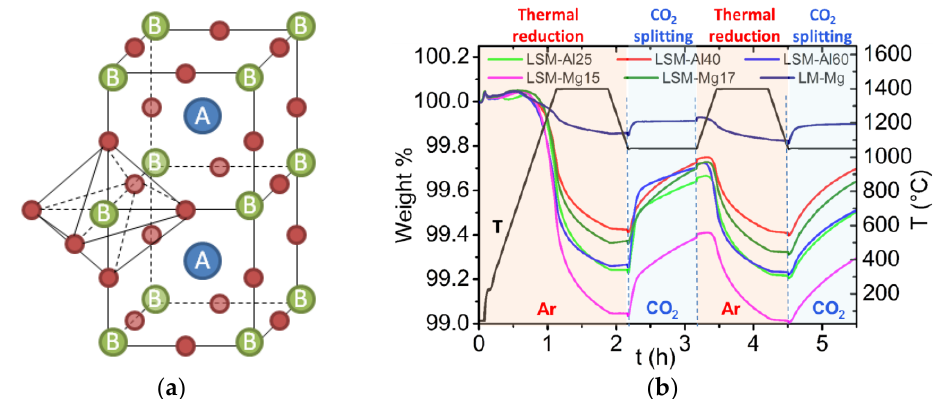
Figure 4. Perovskite-based cycles: ( a ) Scheme of ABO 3 perovskite structure; ( b ) Reduction and re- oxidation cycles involving La x Sr 1 − x MnO 3 (LSM) perovskites substituted with either Al or Mg in the B site (2 successive cycles, reduction in Ar at 1400 °C and oxidation in 50% CO 2 at 1050 °C).